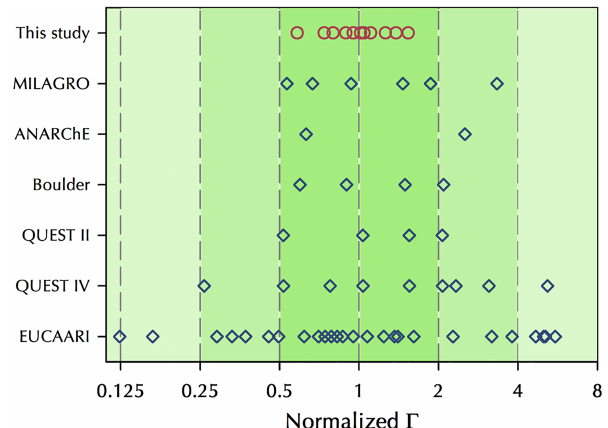
Figure 4. Normalized growth enhancement factor, (cid:48) , in this cam- paign in comparison to those reported for other campaigns. (cid:48) was normalized by the geometric mean value in each campaign.